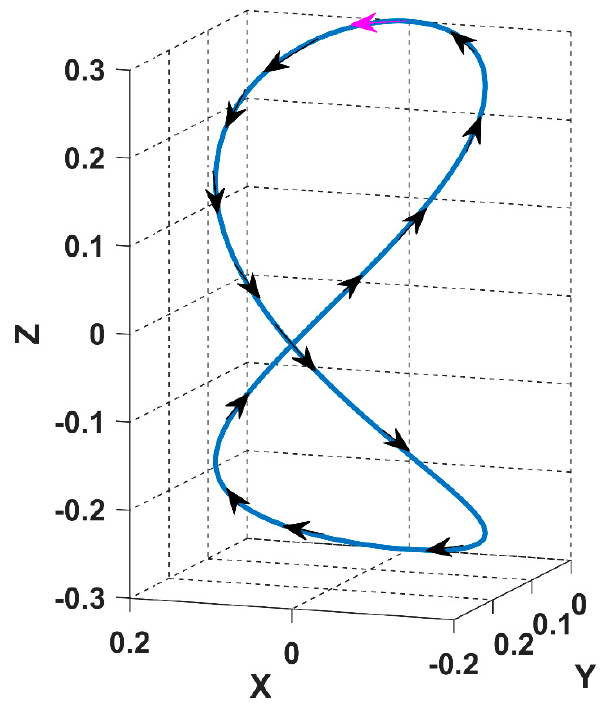
Figure 18. The 8-shaped receiver trajectory 𝝘 starts from the pink-coloured coil. Figure 19 represents the maximum input power for the 3D WPT system when the receiver is moving according to the 8-shape continuous trajectory. The curve was simulated by rendering the functions of the magnetic resultant θ (t) and β (t), equal to the receiver angular continues trajectory α (t) and φ (t). As is depicted in Figure 20 by a blue and yellow colour, the input power fluctuates between two maxima of 1.3 W and 2.5 W, respectively.